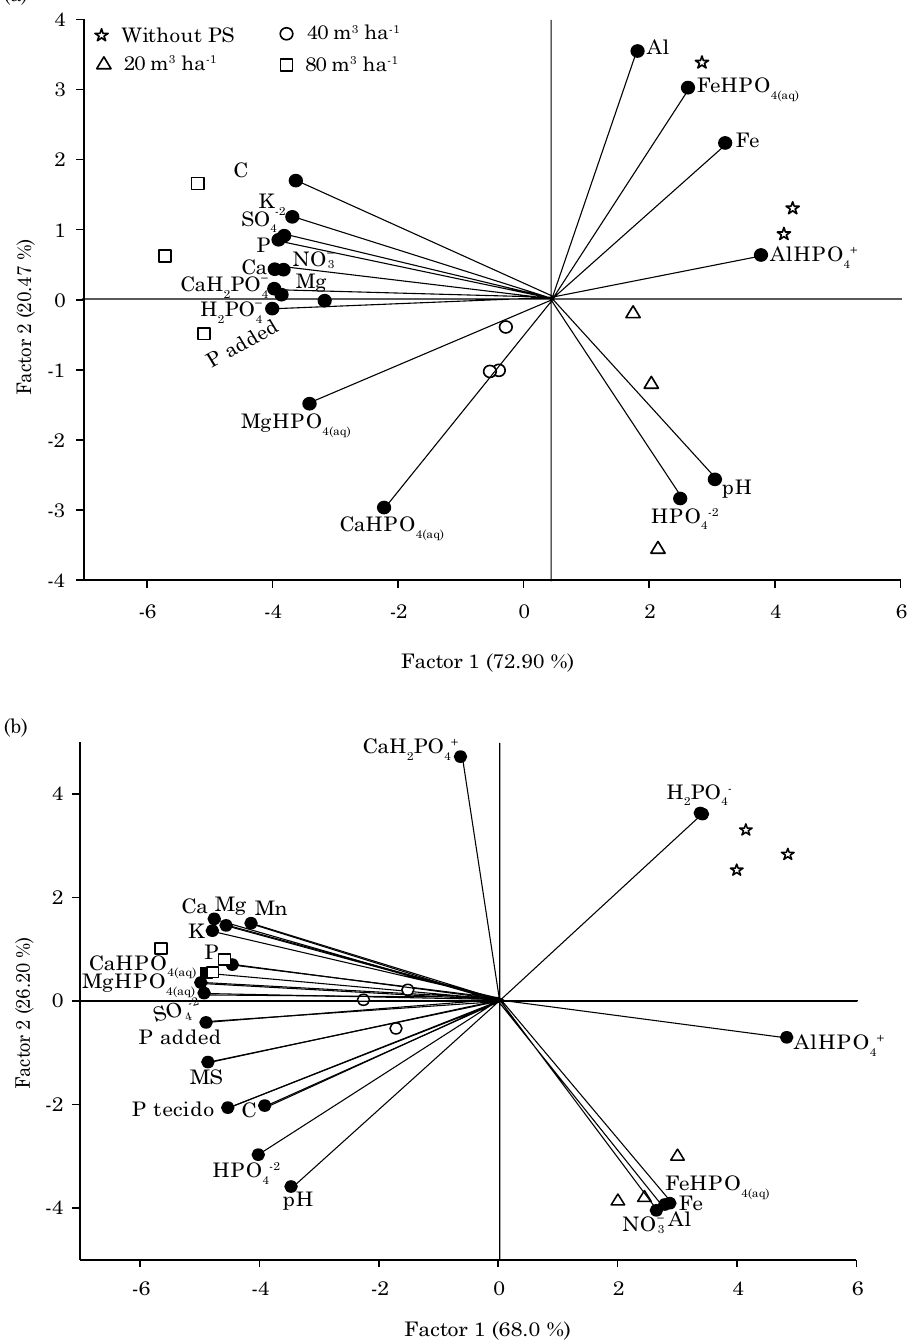
figure 3. relationship between principal component 1 (factor 1) and principal component 2 (factor 2), the chemical species of P and chemical elements in solution in the 1 st (a) and 2 nd sampling (b) in a typic hapludalf soil treated with pig slurry (Ps) rates of 0, 20, 40, and 80 m 3 ha -1